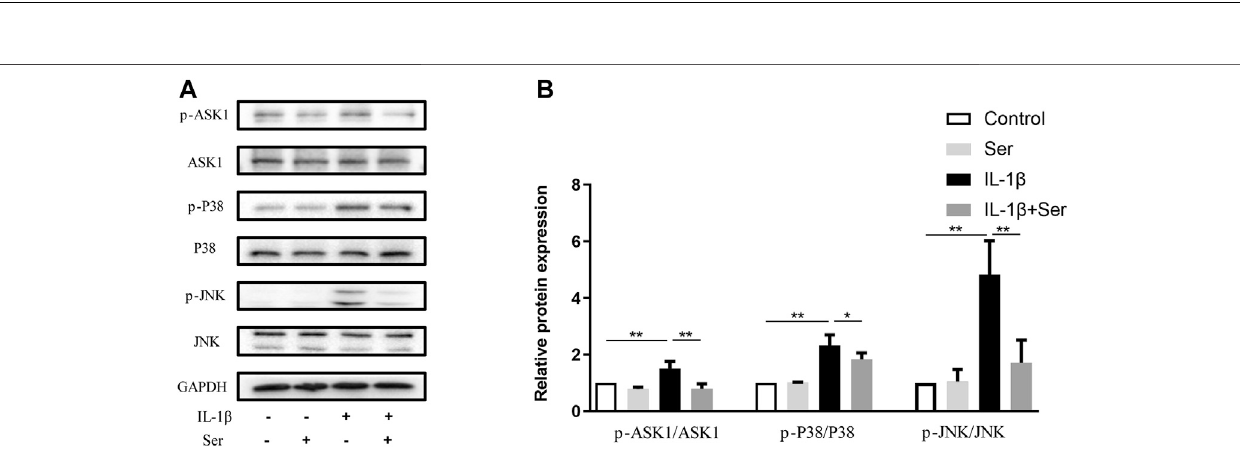
Frontiers in Pharmacology |